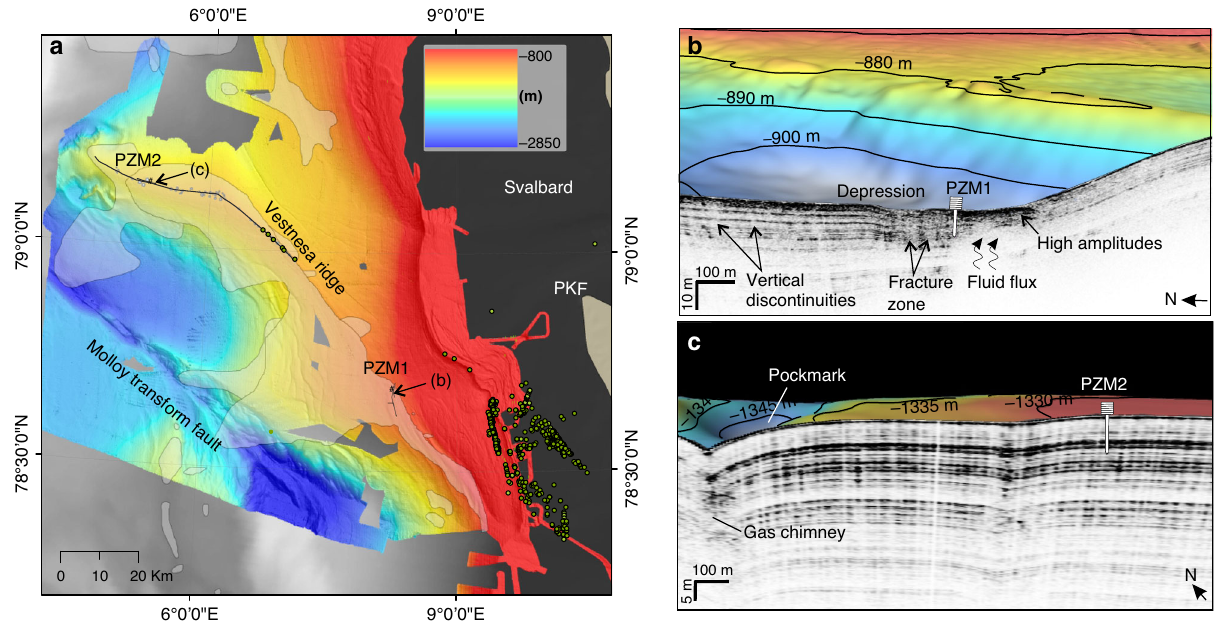
Fig. 1 Study area and distribution of sea fl oor seepage. a Location of investigated sites off the western Svalbard margin. Background bathymetry from IBCAO 55 (gray); higher resolution bathymetry from UiT — The Arctic University of Norway database. The distribution of surveyed gas plumes during yearly expeditions to the area is indicated by green circles. Pockmarks without associated gas plumes on the western Vestnesa Ridge are indicated as gray dots. Shaded areas over the bathymetry correspond to mapped bottom simulating re fl ectors 56 . b Station PZM1 is located within the gas hydrate stability area and near a sediment depression where gas hydrates have been recovered 37 . c PZM2 was deployed in an area characterized by a seismic facies showing parallel re fl ections and no major vertical